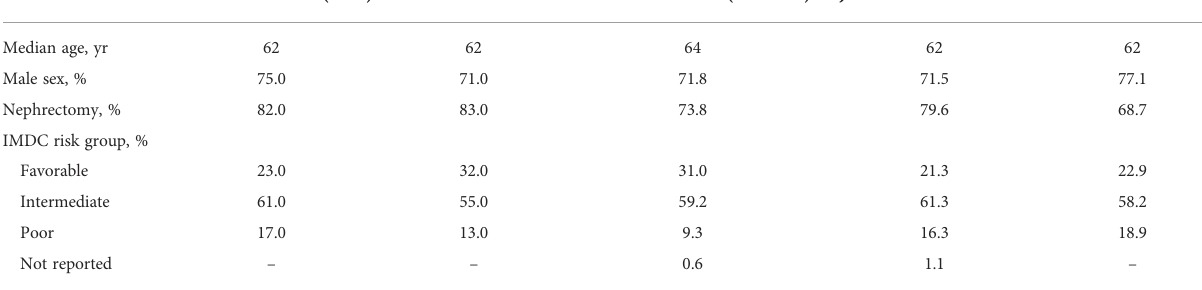
TABLE 2 Baseline characteristics of patients in the experimental arms of included